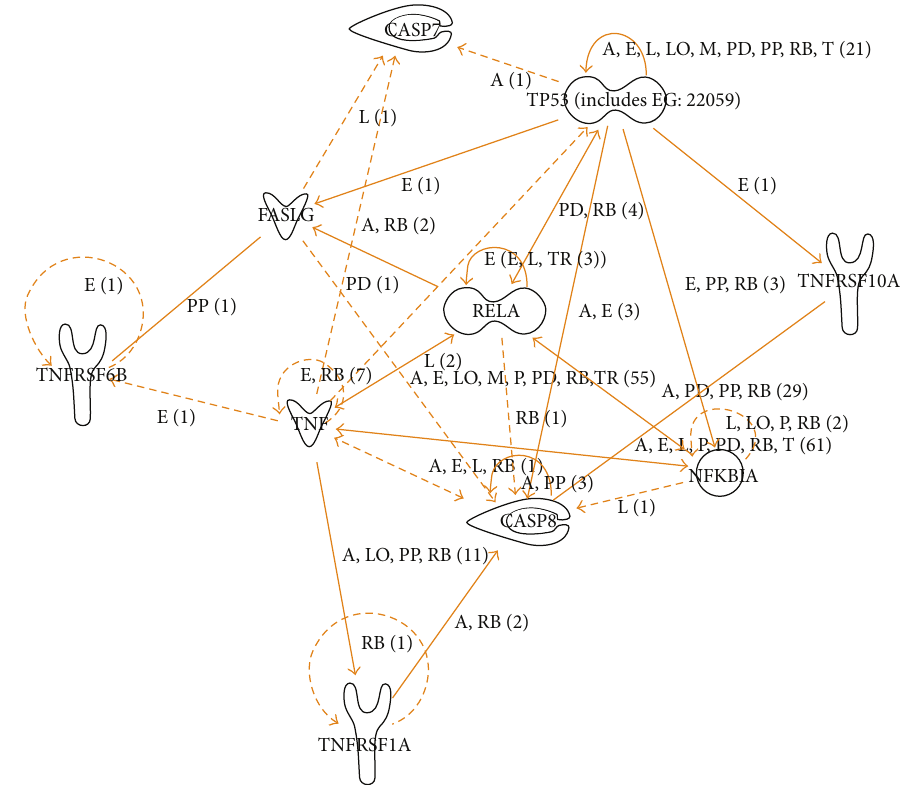
Figure 3: Apoptosis through death receptors: a signaling pathway in TLE(HS). This pathway was generated by the IPA software, based on 10 of the 15 upregulated genes (cutoff 2.0-fold change; see Table 1) in hippocampal tissues from TLE(HS) patients ( 𝑛 = 12 ) compared to post mortem controls ( 𝑛 = 4 ). The biological relationship between two genes, represented as nodes, is shown as a line. Nodes with different shapes indicate different functional class. The pathway created did not include the following genes: NFKB2 , NGFR , TNFSF10 , TNFRSF10C, and TNFSF10D . The function “nervous relaxed” was used. A, activation; E, expression regulation; I, inhibition; L, proteolysis; LO, localization; M, biochemical modification; P, phosphorylation; PD, protein-DNA interaction; PP, protein-protein interaction; RB, regulation of binding; T, transcription; and TR,